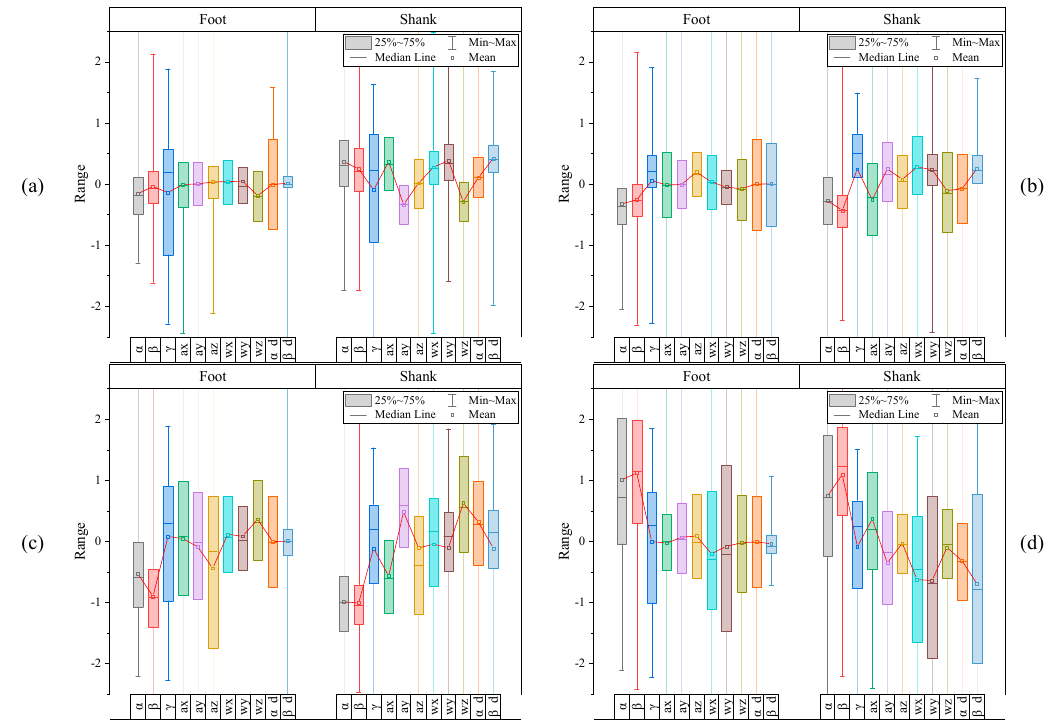
Figure 12. Box plot results of the feature dataset after standardization with mean, standard deviation for each label, ( a ) label 2, ( b ) label 3, ( c ) label 4, ( d ) label 5.